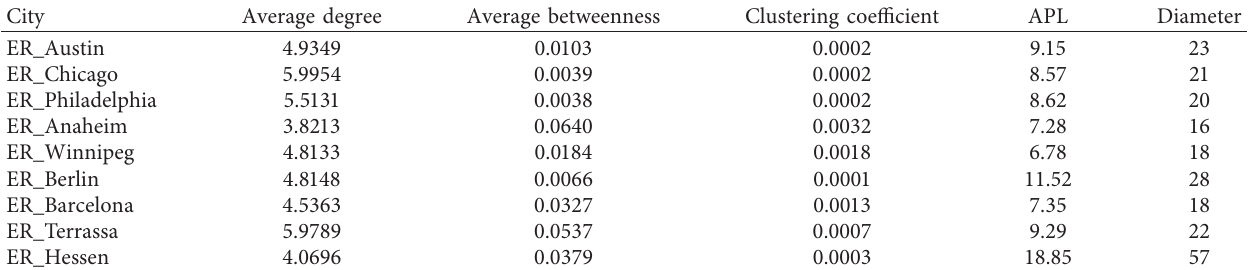
Figure 6: Correlations between APL , diameter, and the size of nine URNs. Table 5: Indices of ER graphs corresponding to the